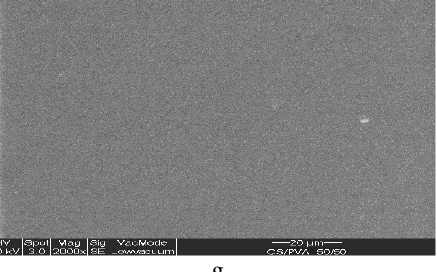
Figure 2. The scanning electron micrographs of pure CS film, pure PVA film and CS/PVA blend films; (a) pure CS, (b) pure PVA, (c) 90/10, (d) 80/20, (e) 70/30, (f) 60/40 and (g) 50/50